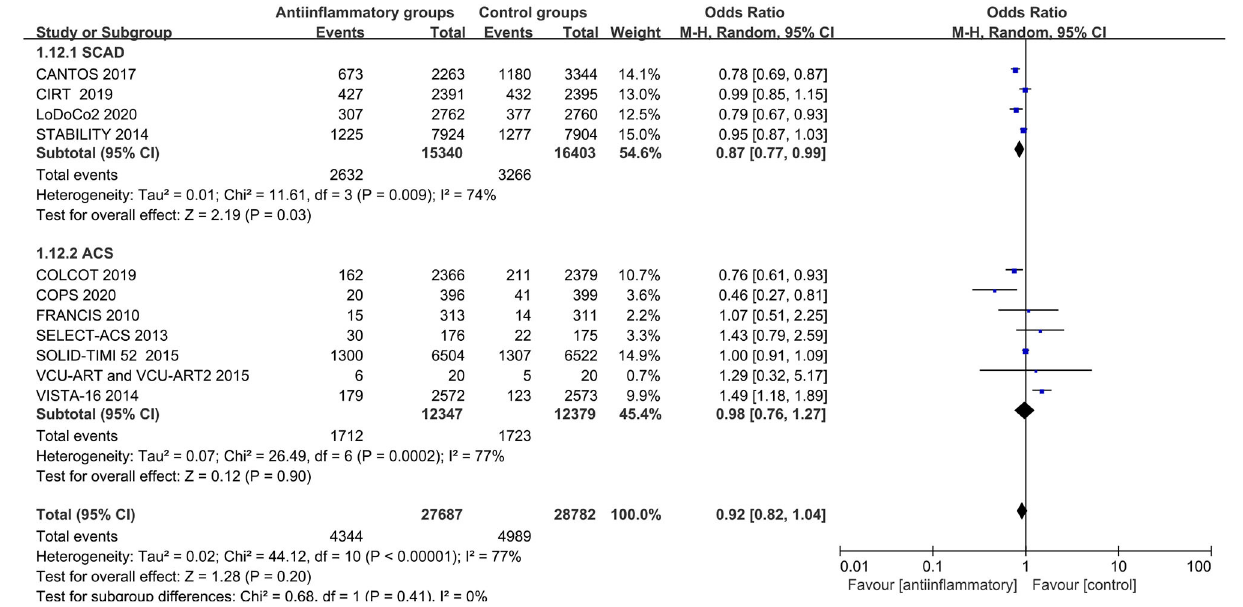
FIGURE 3 | Forest plots of studies evaluating secondary end points in patients with stable CHD vs. ACS.